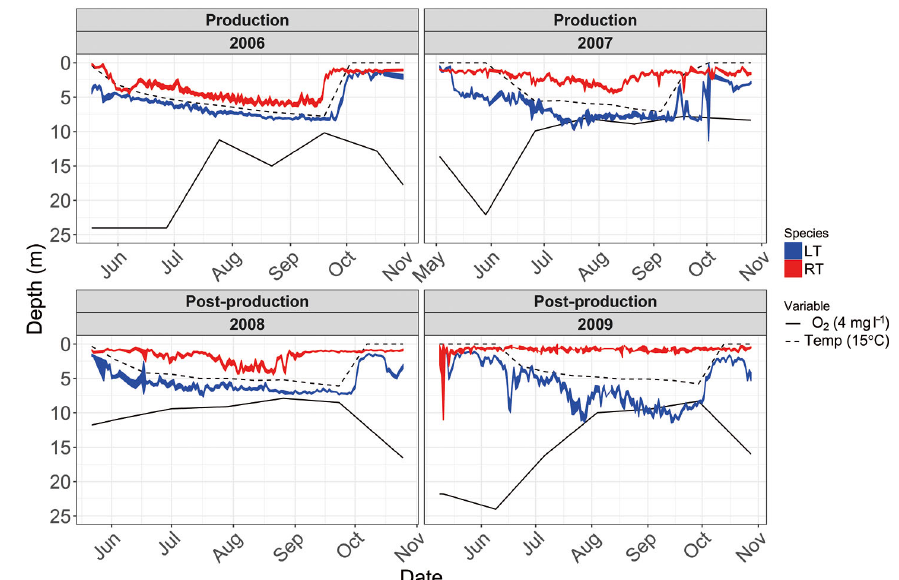
Fig. 4. Mean daily depths (± 95% CI) of escaped rainbow trout Oncorhynchus mykiss (red) and native lake trout Salvelinus namaycush (blue) in Lake 375 during production and post-production of a model aquaculture facility. Optimal oxy-thermal habitat for lake trout is bounded by the upper water temperature of 15°C (dashed line), and the lower oxygen threshold of 4 mg l −1 (solid